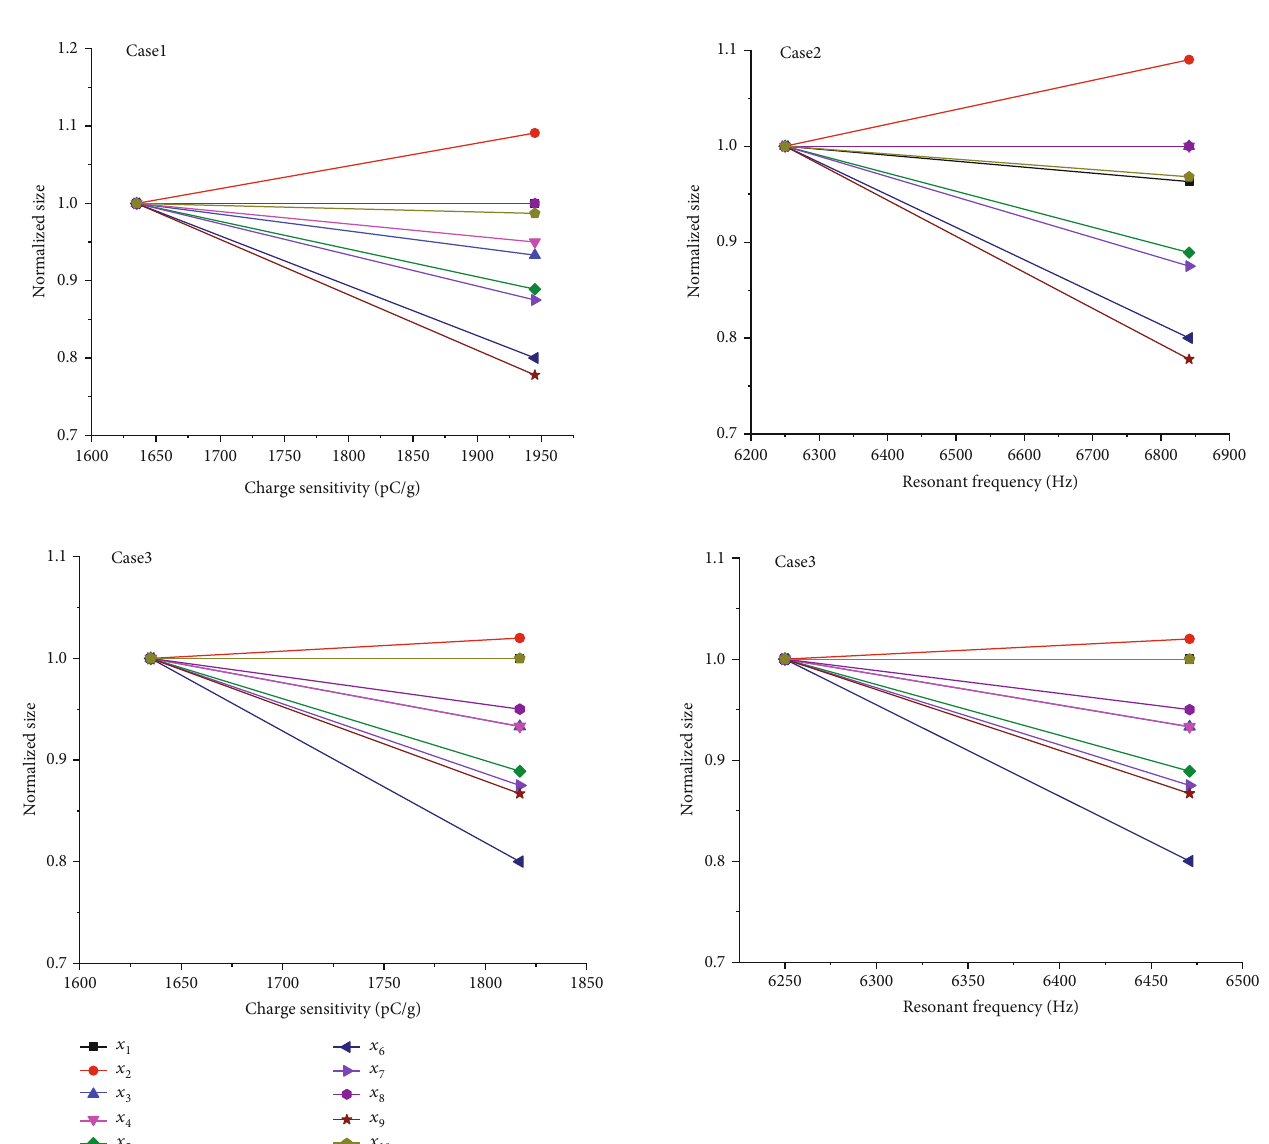
Figure 14: In all cases, the change in the normalized size of each design variable is relative to the reference